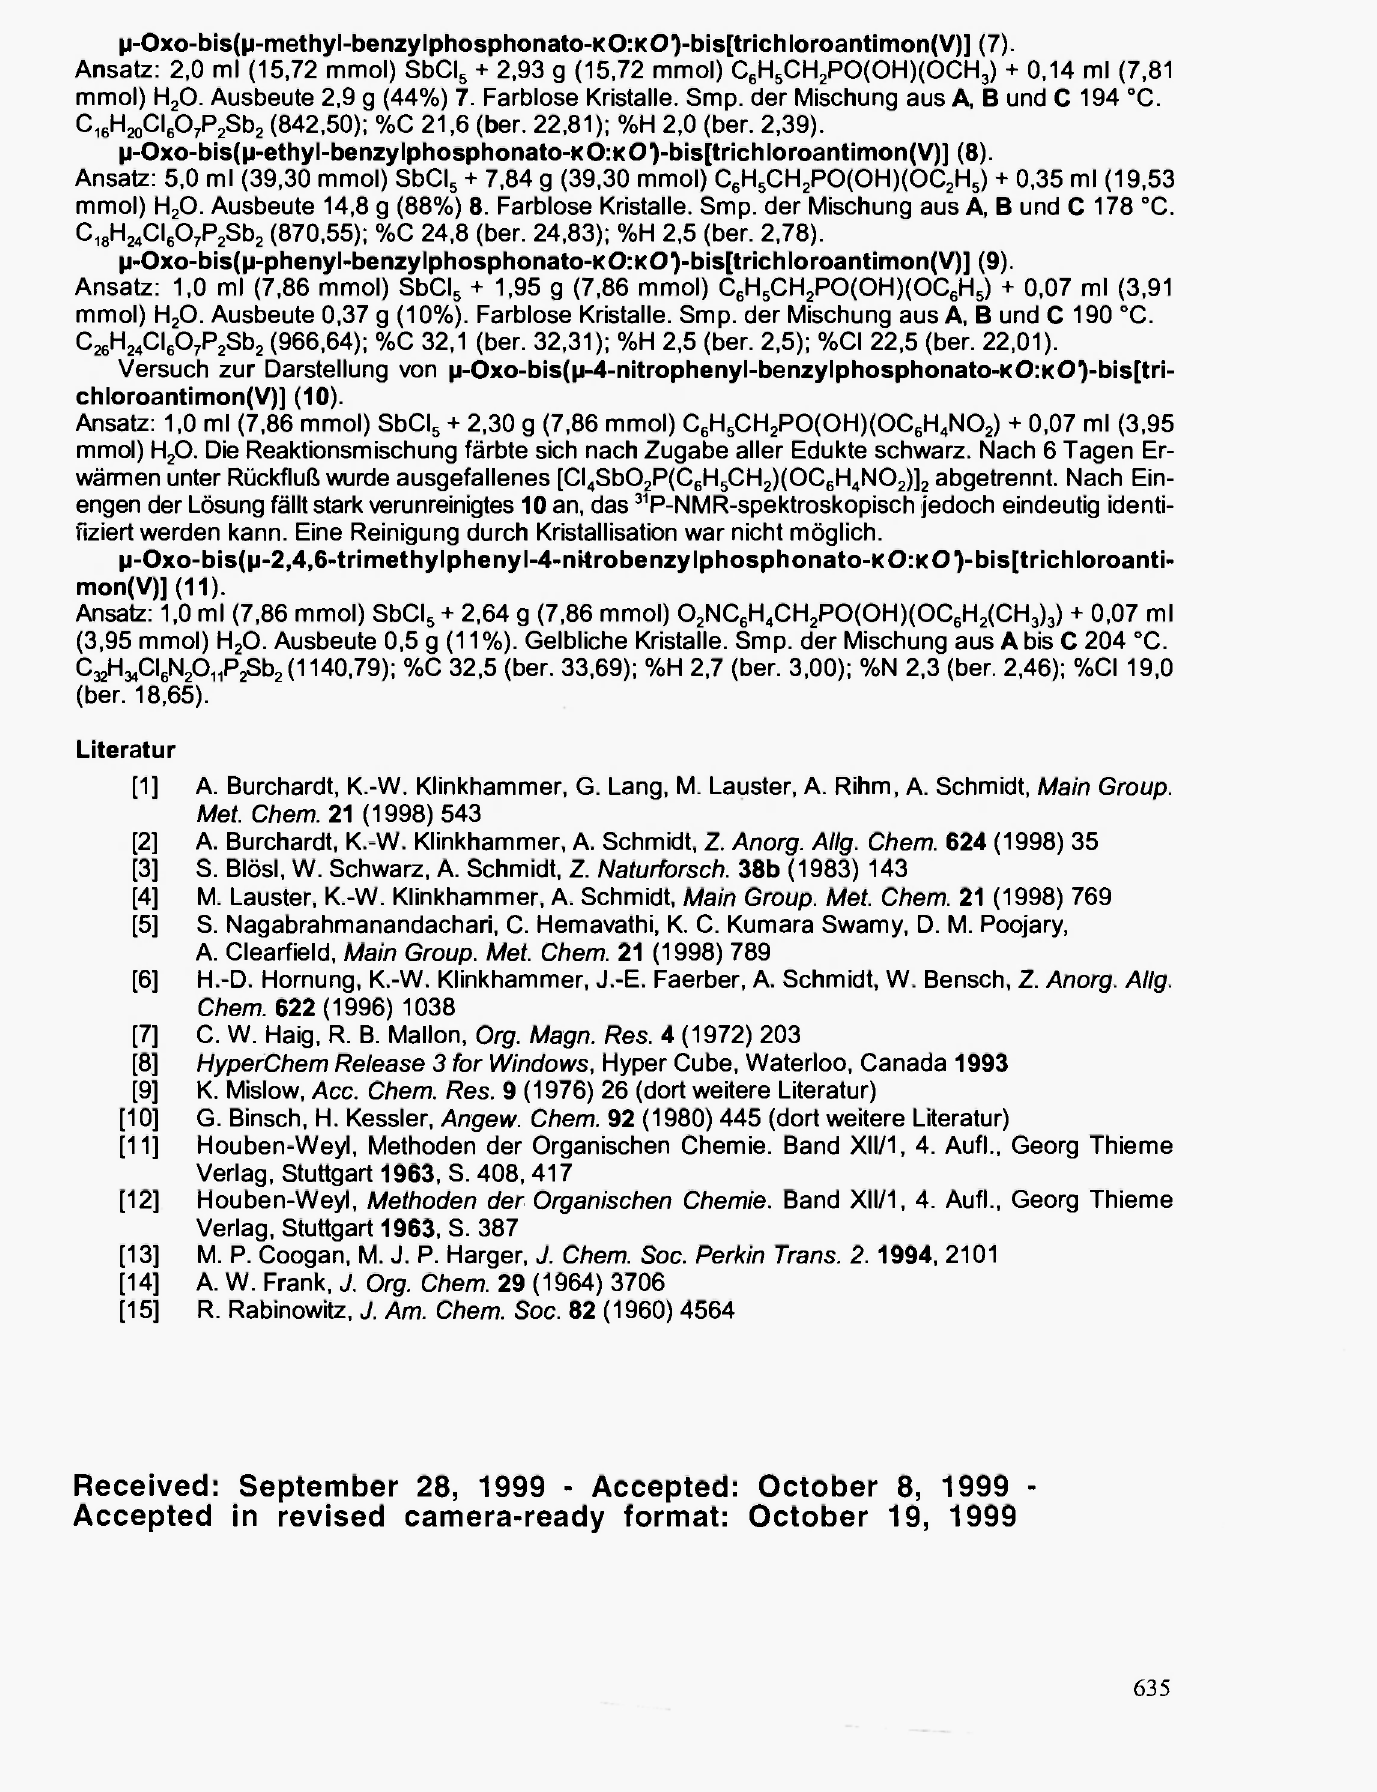
fiziert werden kann. Eine Reinigung durch Kristallisation war nicht möglich. mon(V)]